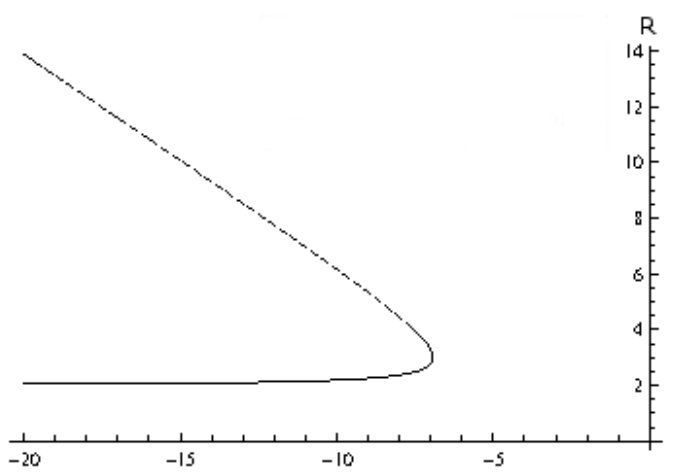
Figure 2. The McVittie apparent horizons in a phantom-dominated universe (here w = − 1.5 and t rip =